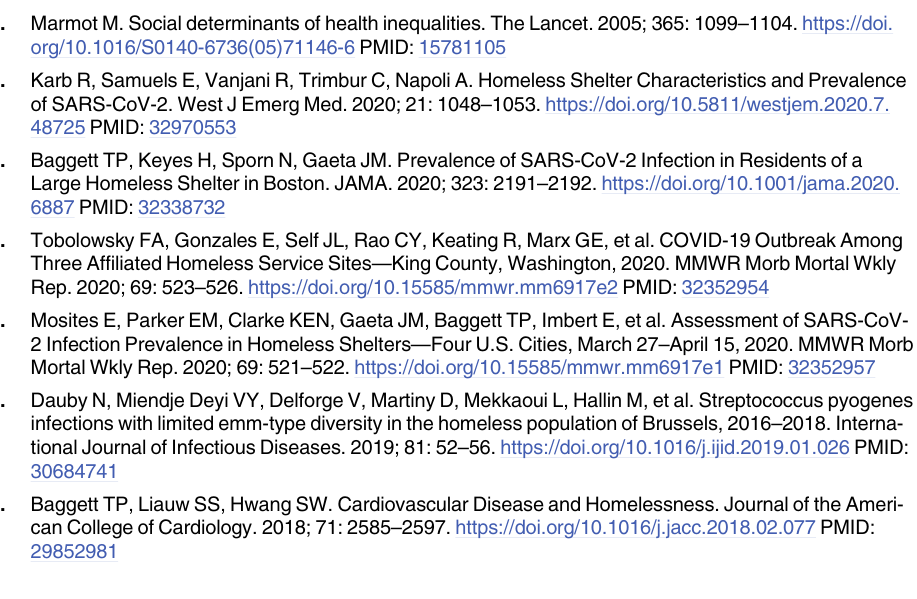
S1 Fig. Kobo Collect form survey recorded